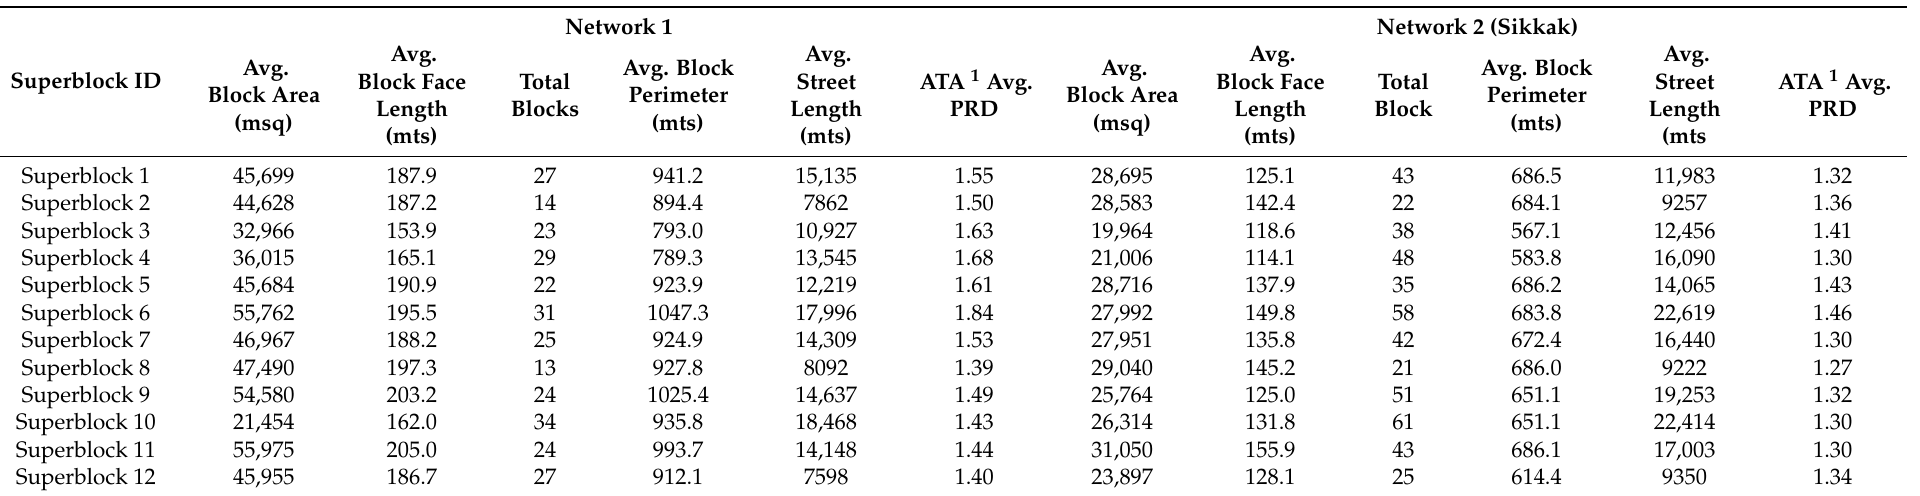
Table 4. Summary of the block size characteristics and the result of PRD for the two tested